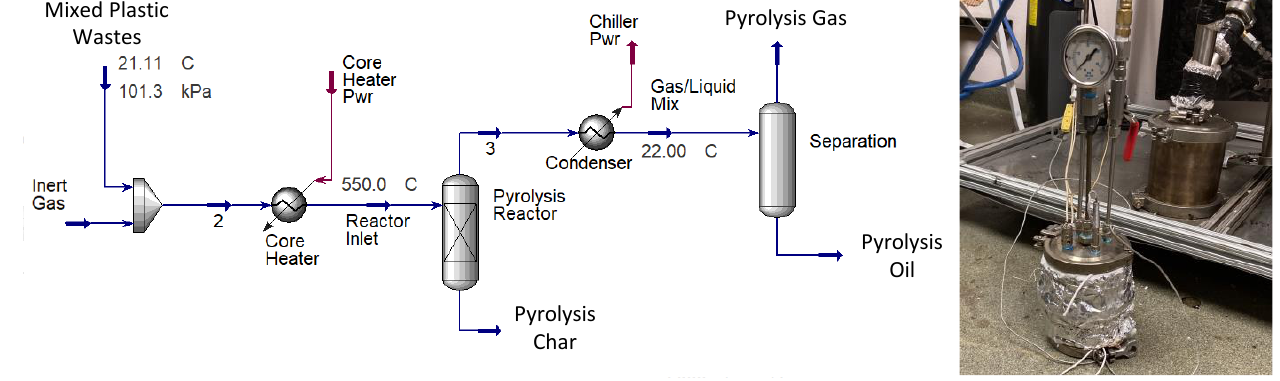
Figure 2. Fixed bed (batch) slow pyrolysis reactor for oil and char production from PS.